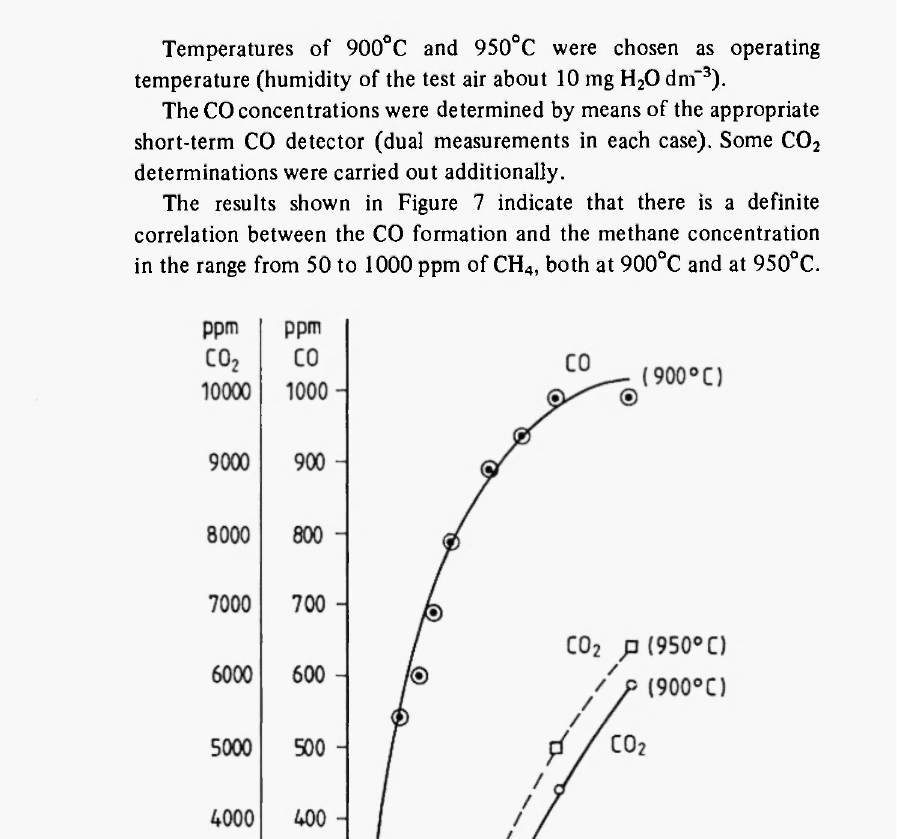
Fig. 7: Results of CH 4 measurements using a pyrolysis system in combination with detector tubes. CO and COj concentration as a function of temperature and CH 4